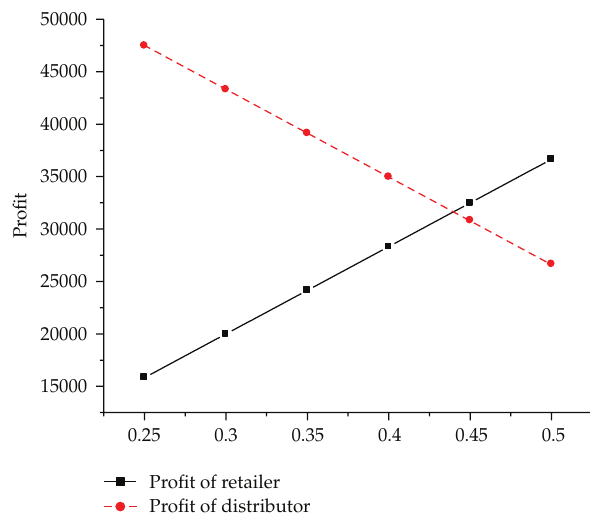
Figure 3: Behavior of retailer’s and distributor’s profit functions with respect to ρ